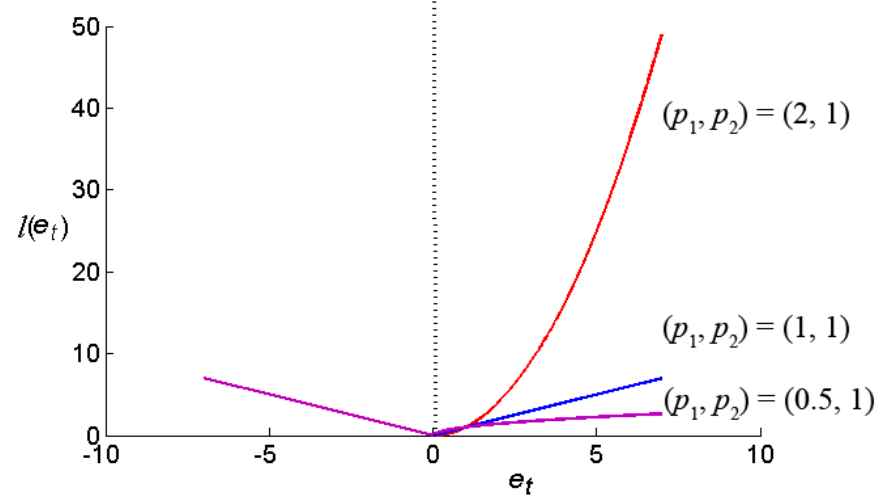
Figure 3. l in Type II Asymmetric Loss Function with Different aII